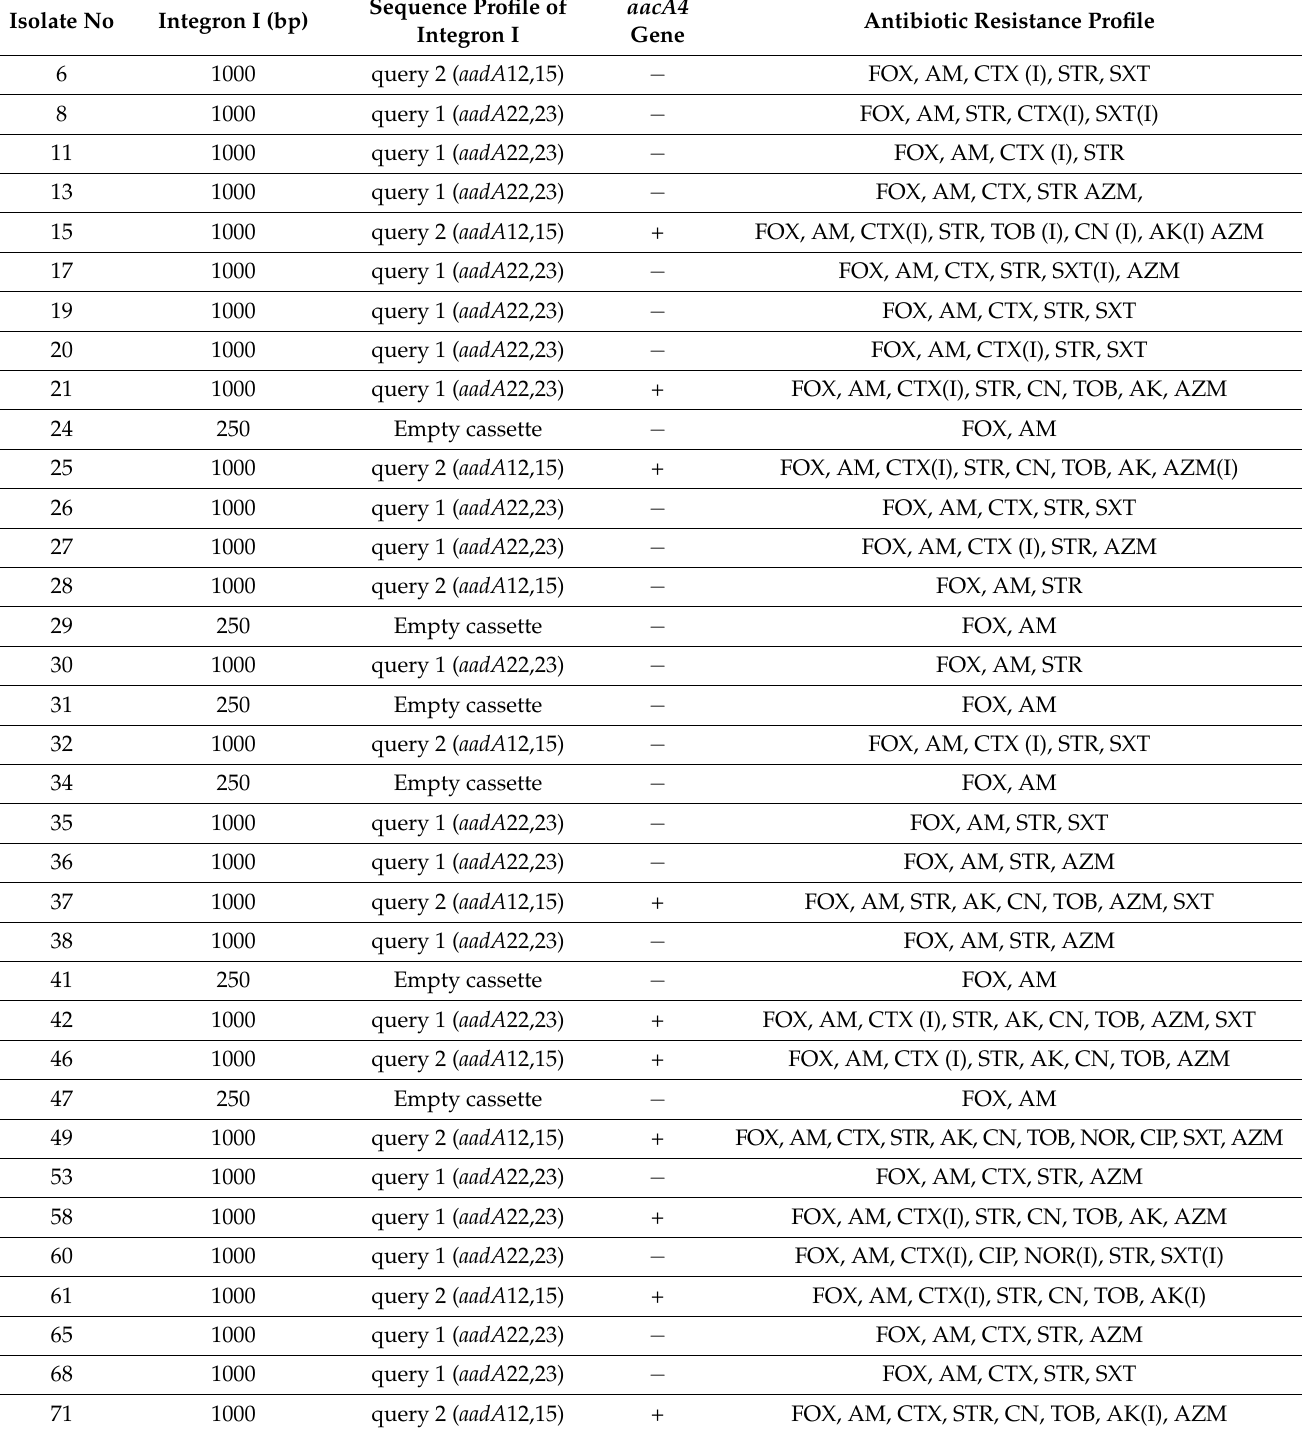
Table 1. Resistance profile and characters of integron I-positive MRSA